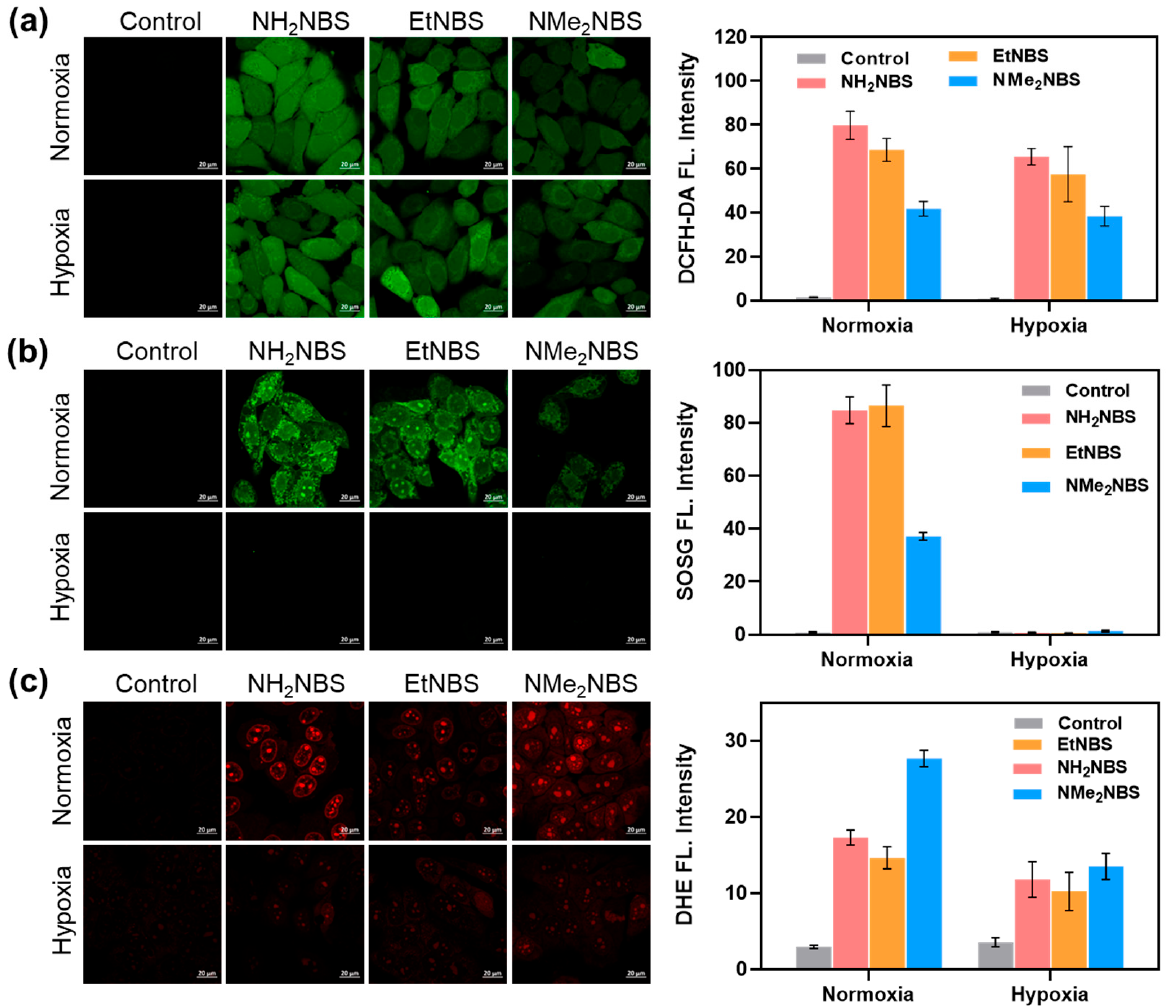
Figure 3. Confocal image of photoinduced ROS detection in HepG2 cells incubated with three PSs and different fluorescence probes under normoxia and hypoxia. ( a ) DCFH-DA for ROS. ( b ) SOSG for 1 O 2 . ( c ) DHE for O 2 − • radical.